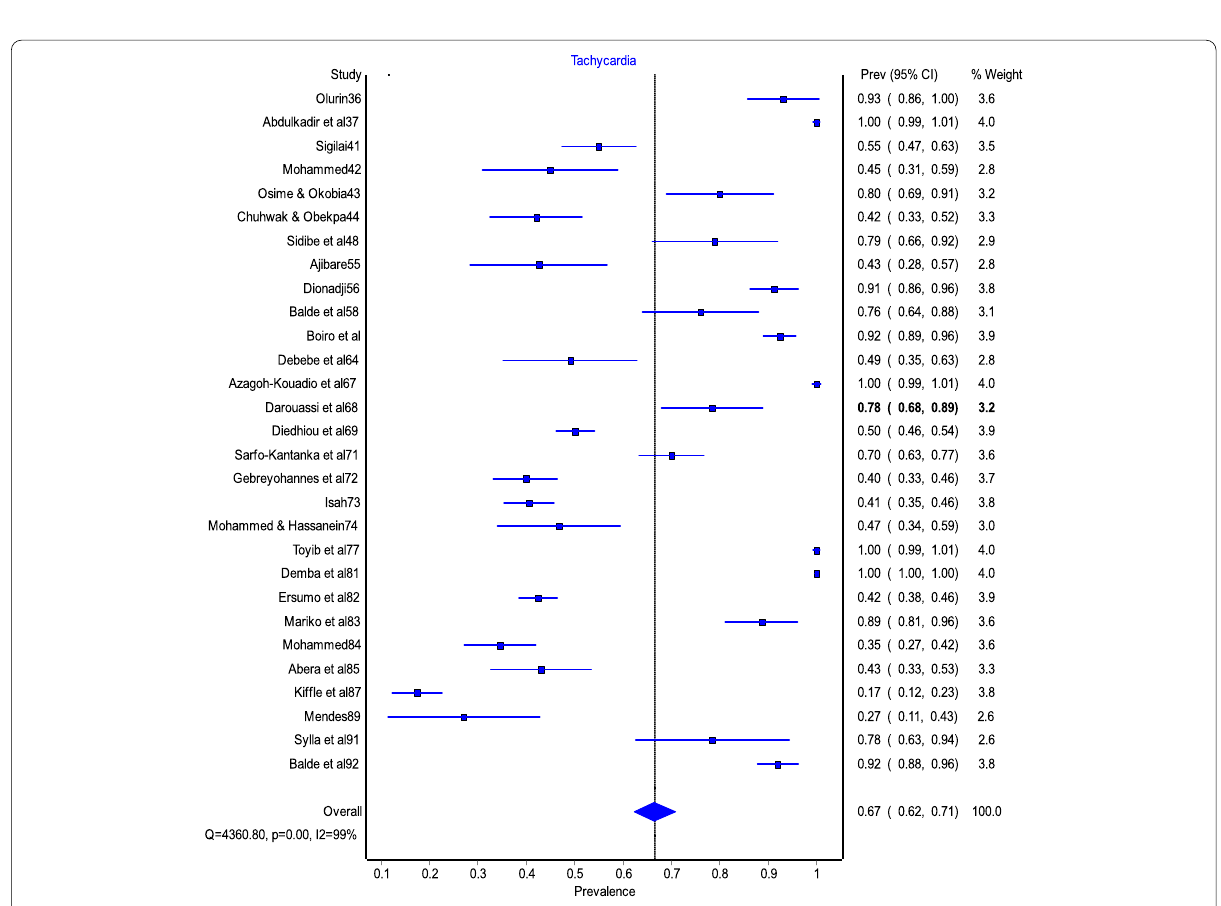
Fig. 13 Forest plots showing the frequencies of